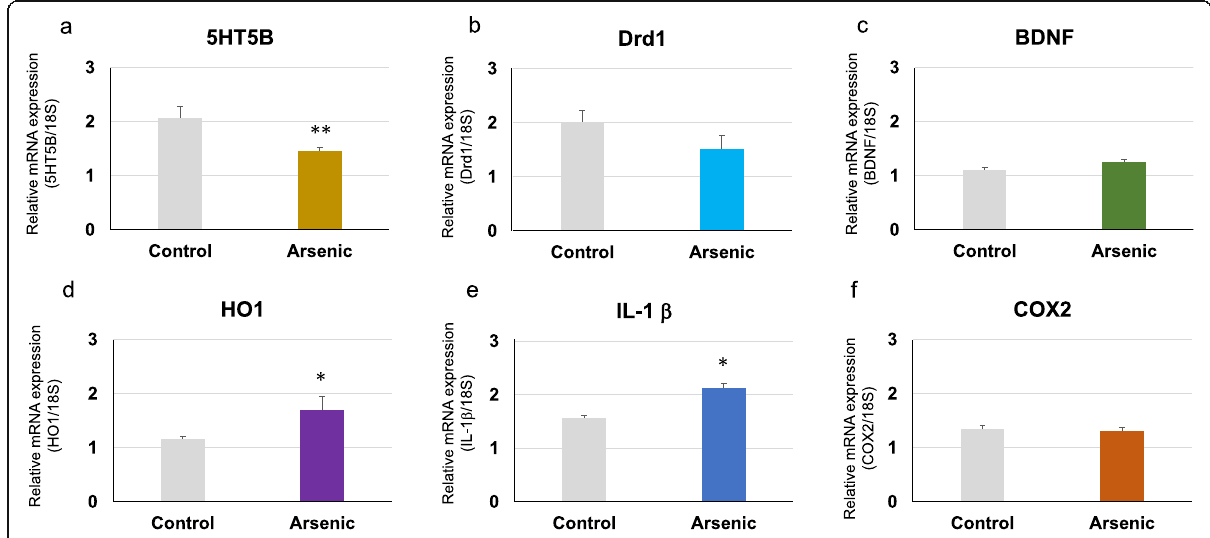
Fig. 5 Messenger RNA expression level. a 5-HT 5B, b Drd1a, c BDNF, d HO-1, e IL-1 β , and f COX-2 in the prefrontal cortex of the control group and the arsenic group of 41-week-old F2 male mice. Each bar represents the mean ± SE ( n = 7 – 8, * p < 0.05, ** p < 0.01)